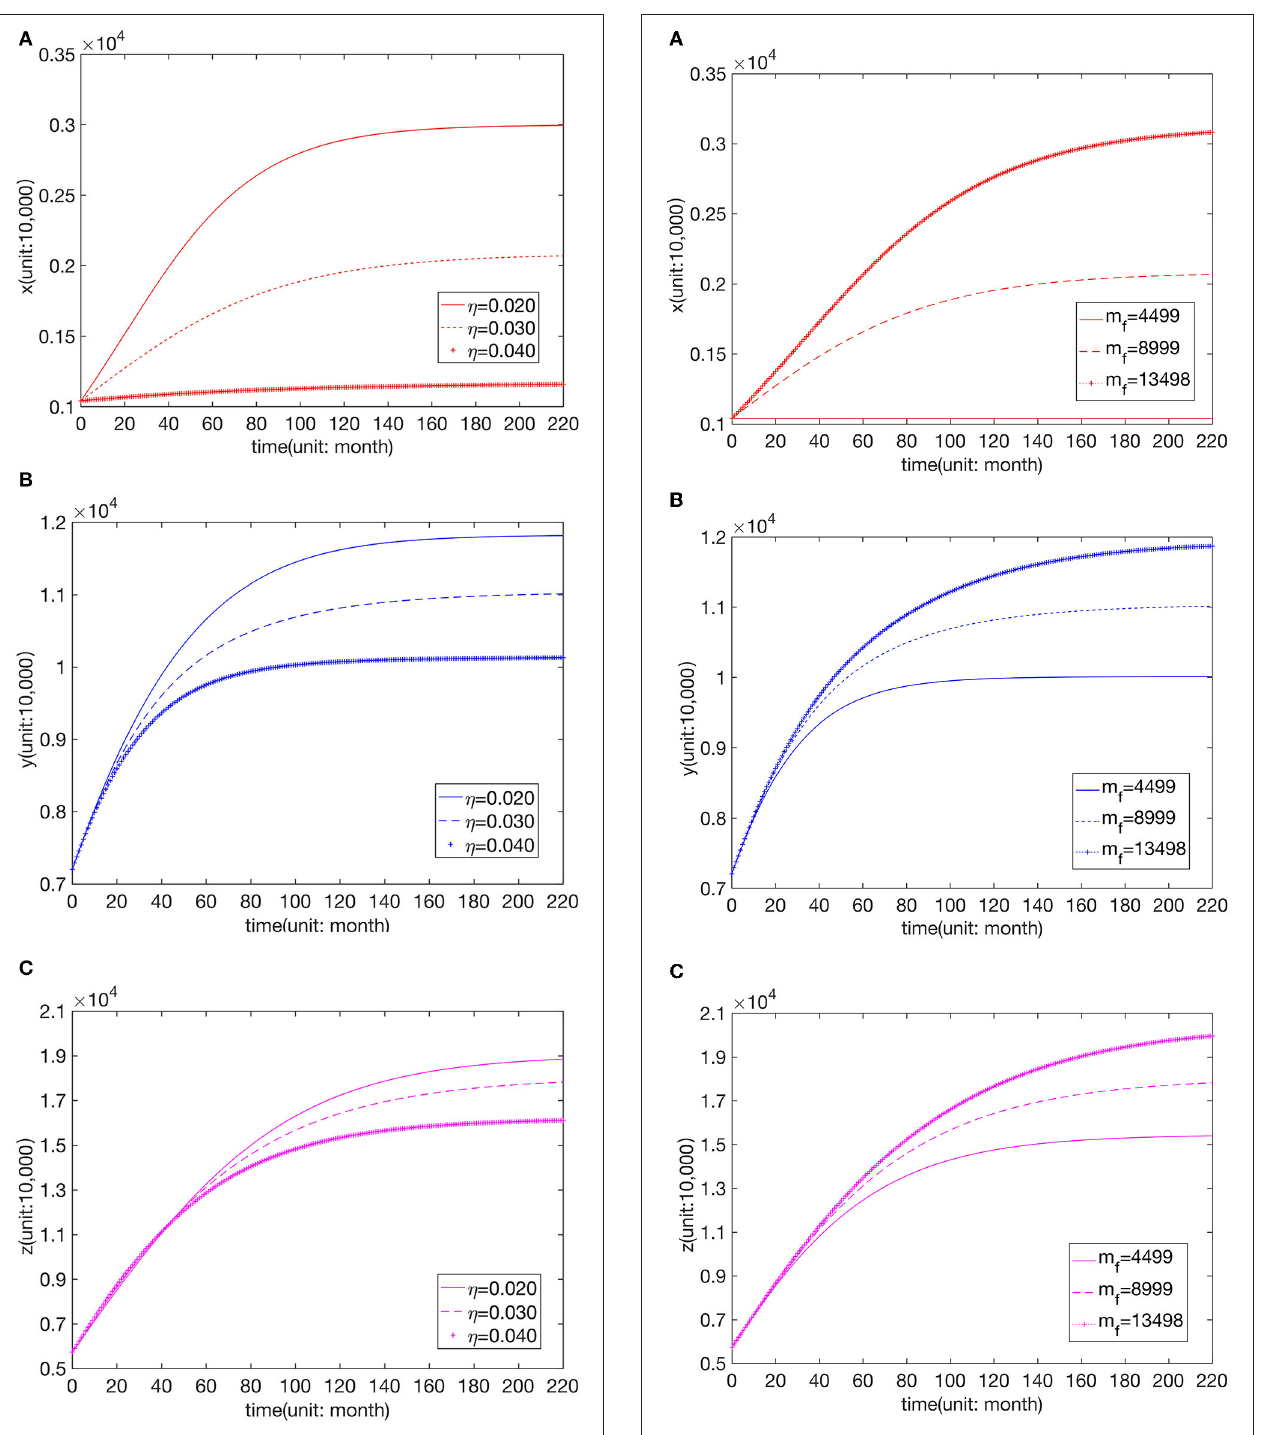
of visits to SLHs increases, and that to TLHs reduces. In contrast, the distribution of FLH patients is not affected.